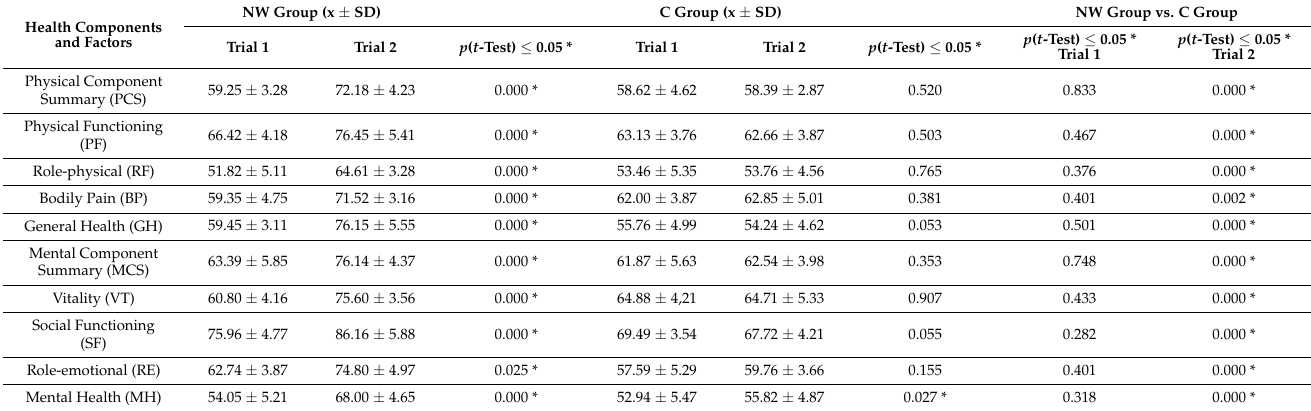
Table 2. Comparison of the mean values of the quality of life between NW and C